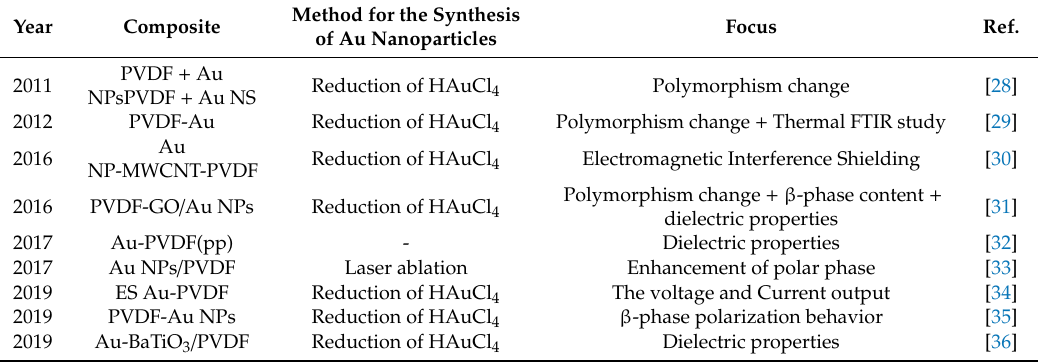
Table 1. Nanocomposites based on PVDF and Au nanoparticles from previous literature.